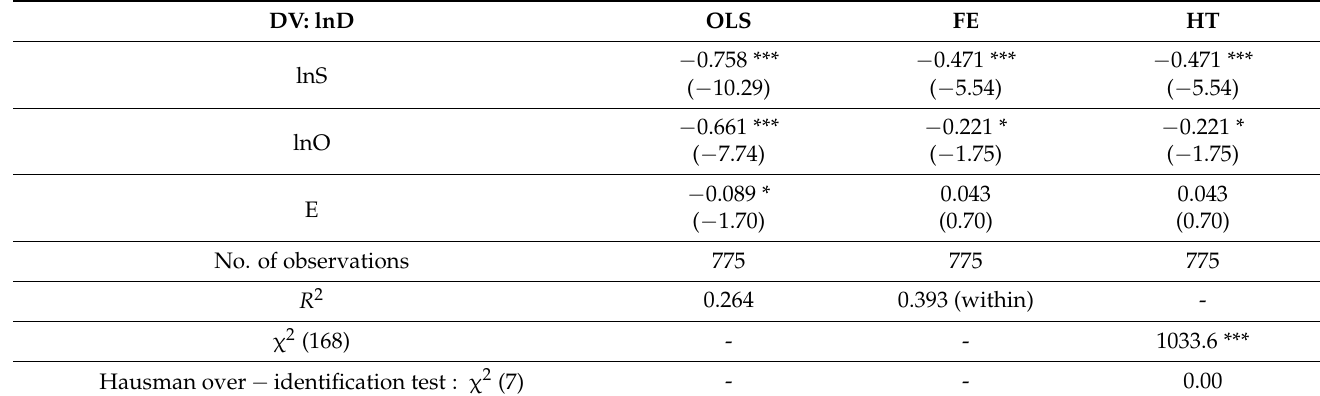
Table 4. Regression results for Equation (1) without the variables of interest.